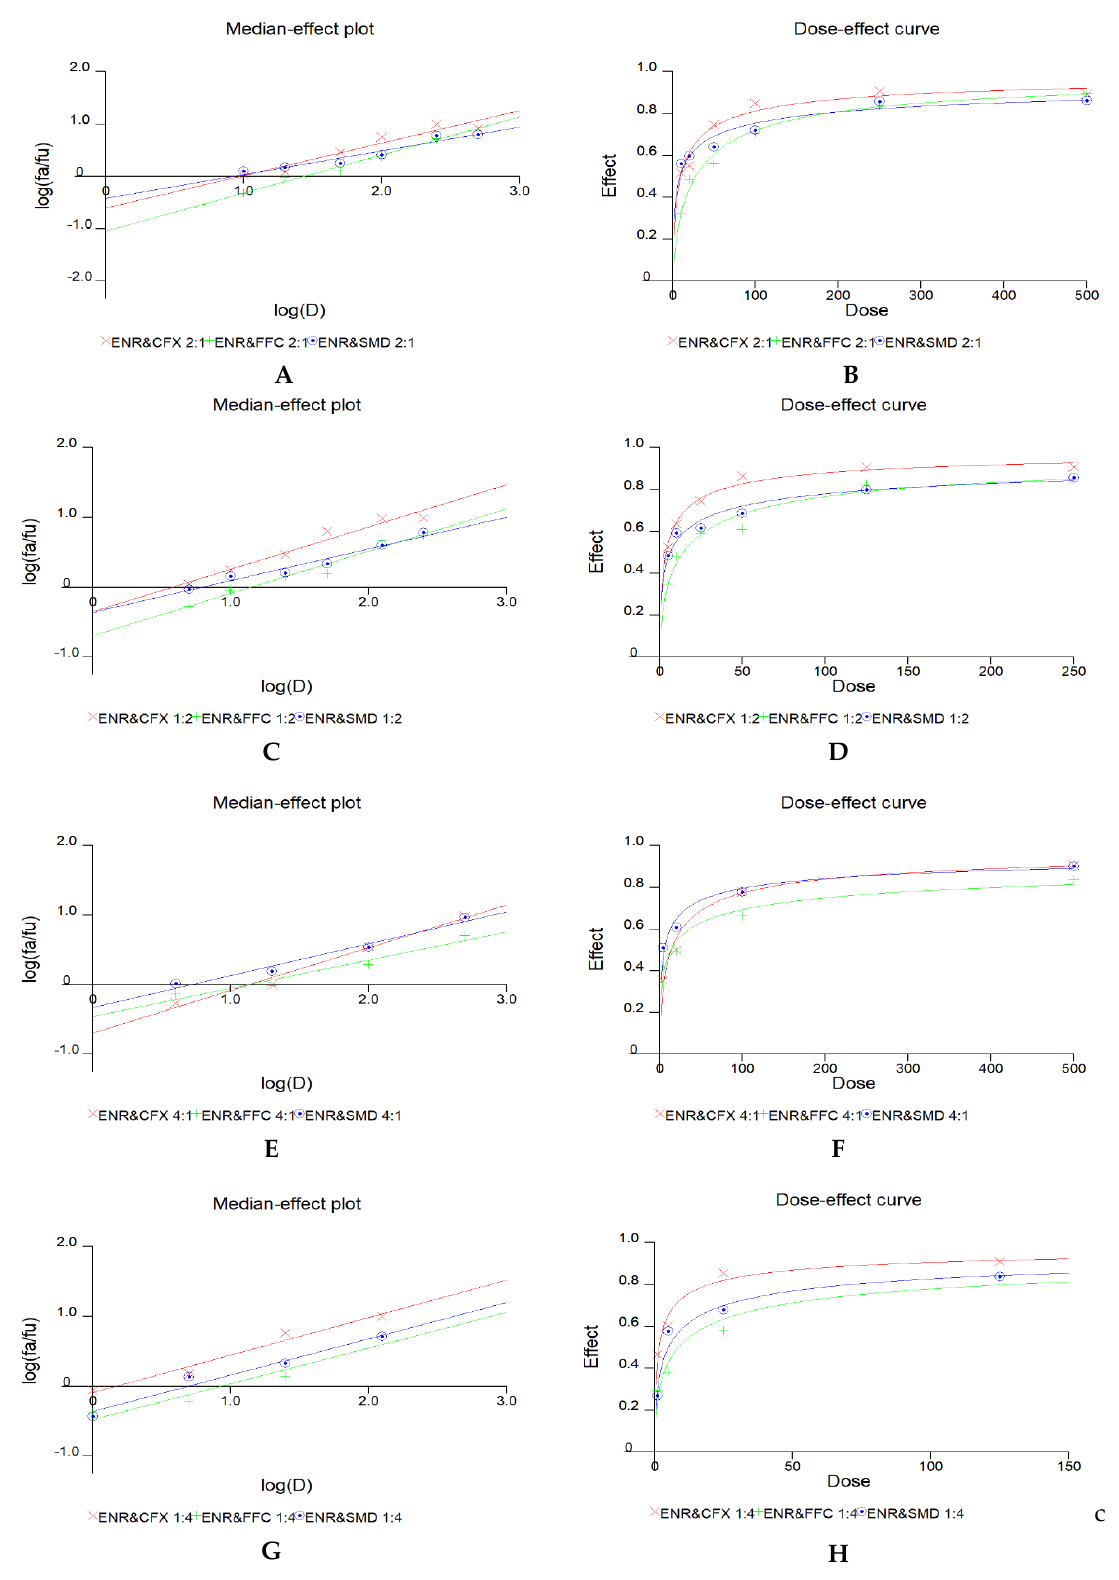
Fa, fraction affected by dose; M, shape parameter; Dm, median-effect drug dose (represented as the concentration of enrofloxacin (μg·L −1 )); CI, combination index.